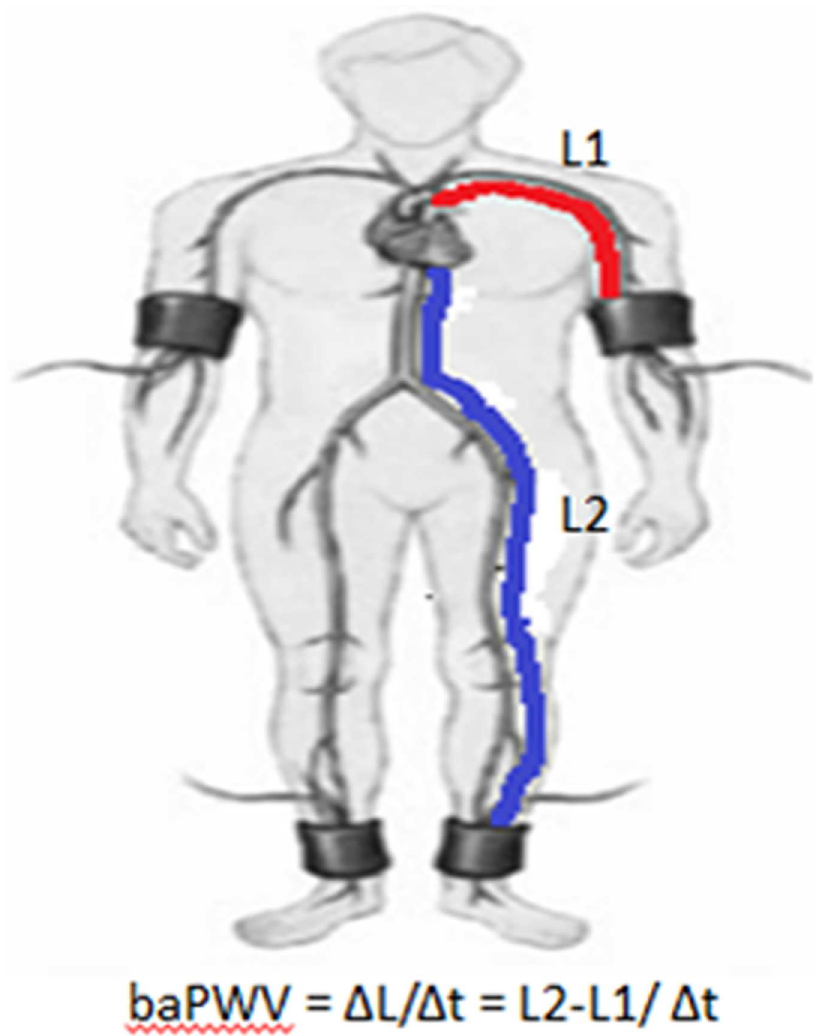
Fig 1. The working principle of baPWV measurement. The dictancefrom heart to the brachialarteries is marked by the red lines and is representedby L1. The dictancefrom heart to the ankle arteries is marked by the blue lines and is represented by L2. Thus, baPWV = Δ L/ Δ t = L2-L1/ Δ t.